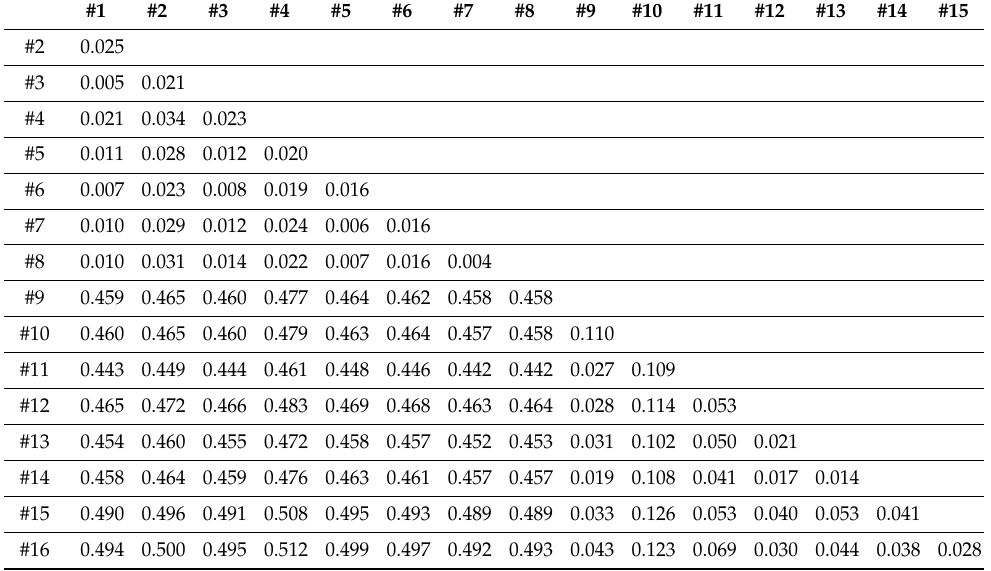
Figure 8. Distributions of the Hu moments via different transformations, in which the elements of a1–a6 are computed by the Formula (9): ( a , b ) respectively present the values of Hu moments for gestures of Two and Four. Table 1. Distance of modified Hu moments from pairwise